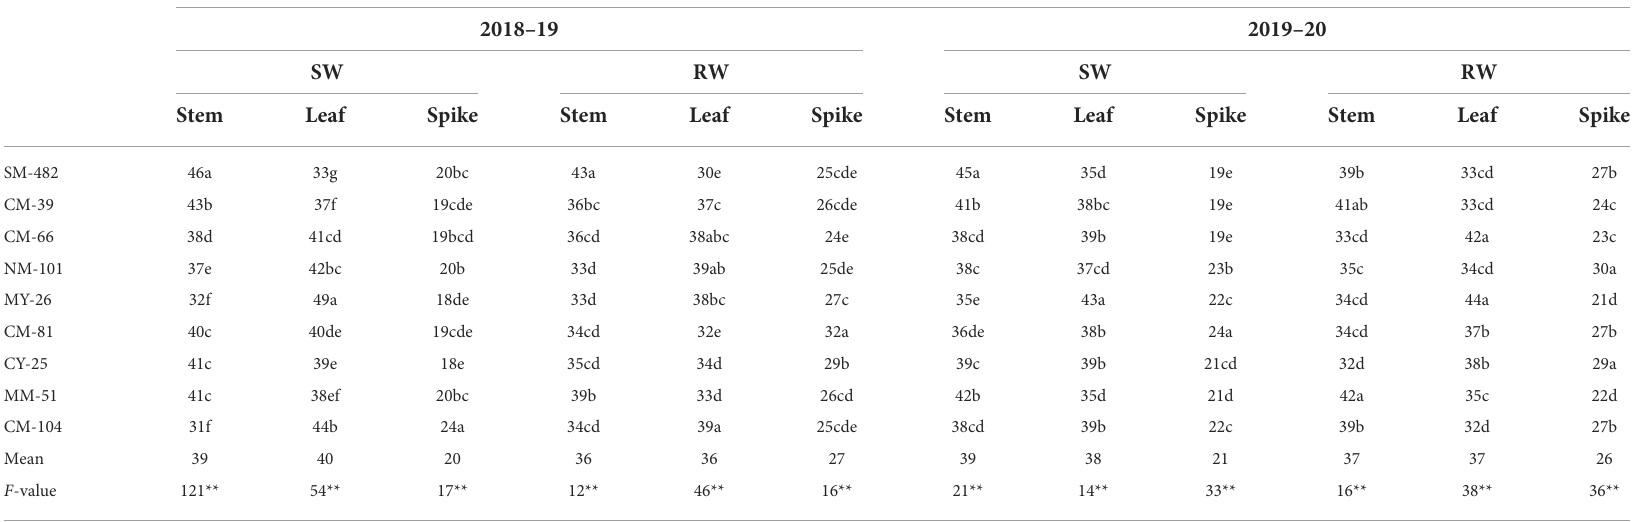
TABLE 7 The N partitioning at anthesis of nine wheat genotypes in two wheat cropping systems and two cropping years. Genotype N partitioning at anthesis